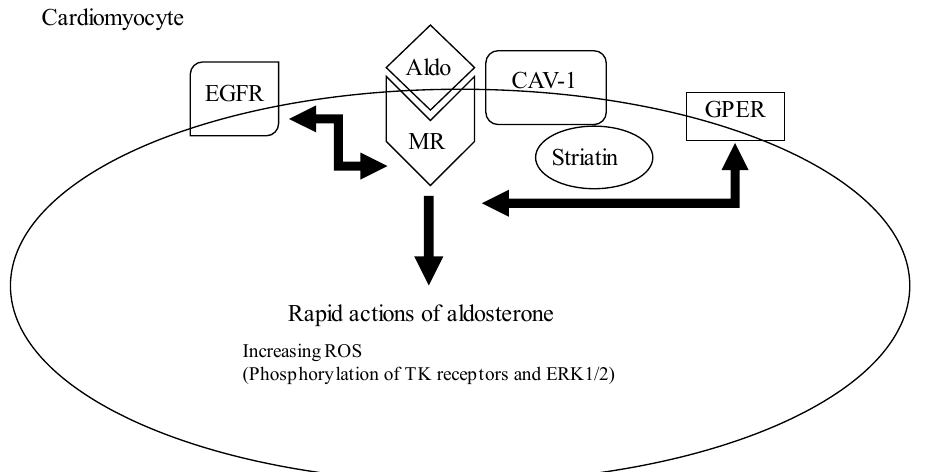
Figure 2. The mechanism underlying the pathological non-genomic effect of aldosterone in cardiomyocytes.